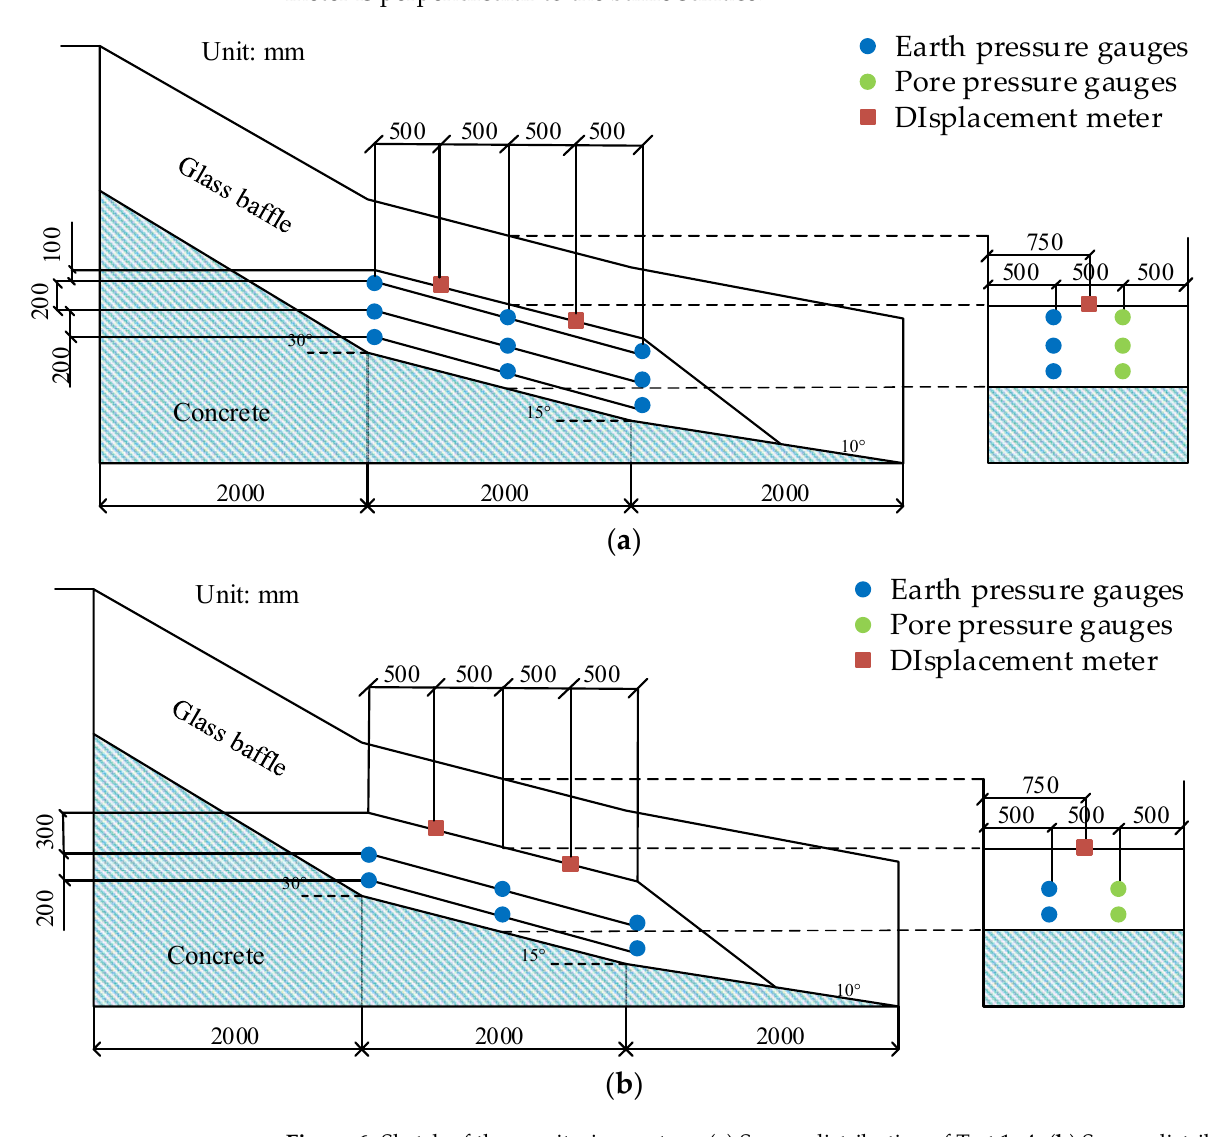
Figure 6. Sketch of the monitoring system. ( a ) Sensor distribution of Test 1~4. ( b ) Sensor distribution of Test 5~6.